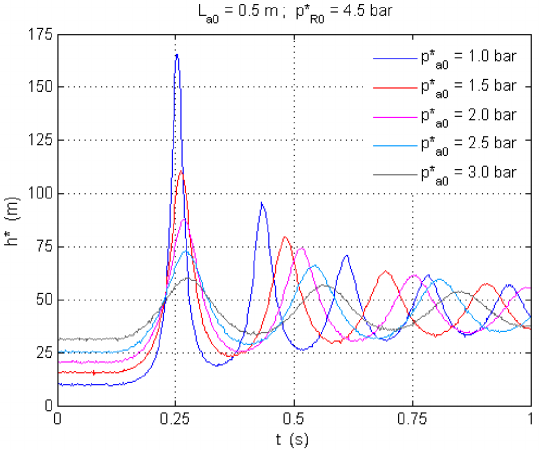
Figure 2. Influence of initial air pocket pressure on the amplitude and frequency of pressure oscilla- tions during pipeline